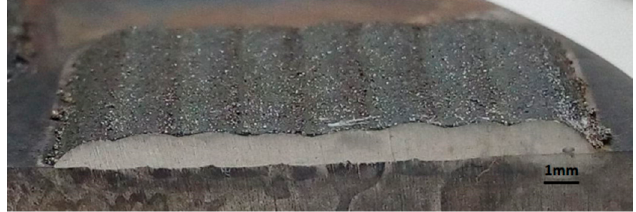
Figure 9. Macrograph of a cross section following the Parallel strategy.